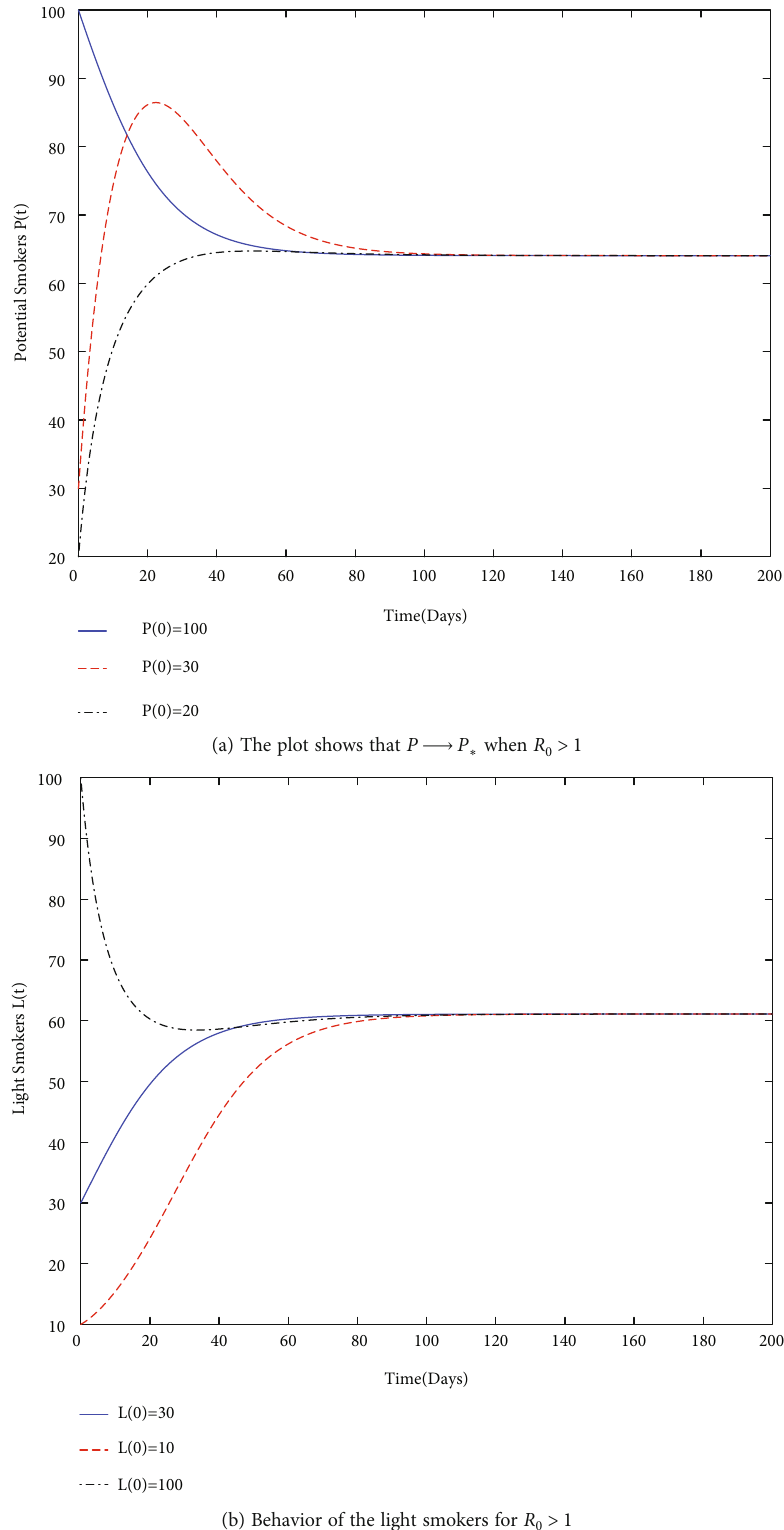
Figure 3: The plot describes stability of smoking present equilibrium E